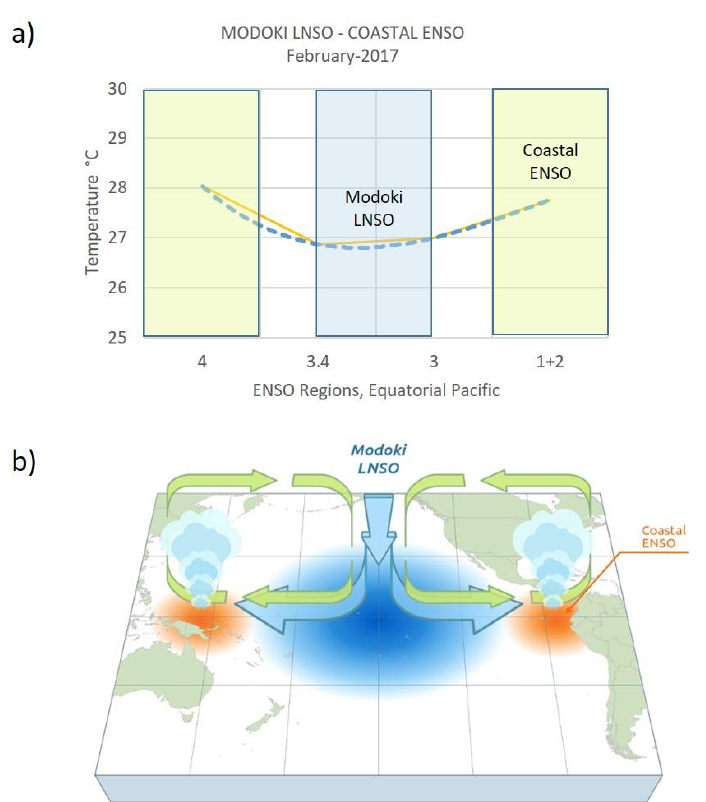
Figure 9. ( a ) PREI index, conjunction of regions 4, 3.4, 3, and 1 + 2. The curve shows the presence of Modoki LNSO in the central region (3.4 and 3). On the right margin the eastern region (1 + 2), coastal ENSO is shown. ( b ) Map of the Pacific Equatorial Region, showing the location of the Modoki LNSO and the coastal ENSO.